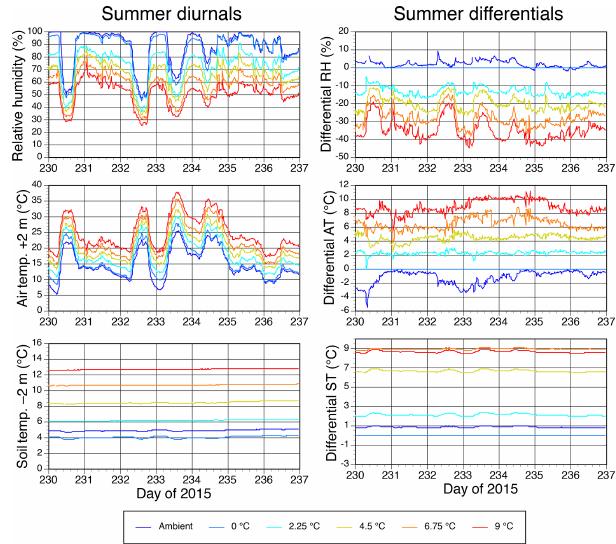
Figure 8. A warm-season, 7-day example of the diurnal variations in air temperature and relative humidity at + 2m, and soil temper- atures at the reference depth of − 2m. Calculated differentials with respect to reference plot 6 are provided in the right-hand column.